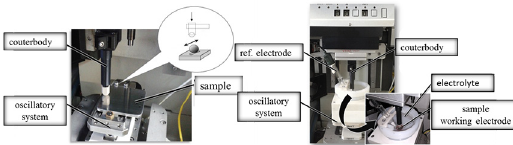
Figure 1: System ball-on-flat. a) dry Test and b) corrosive medium Test.